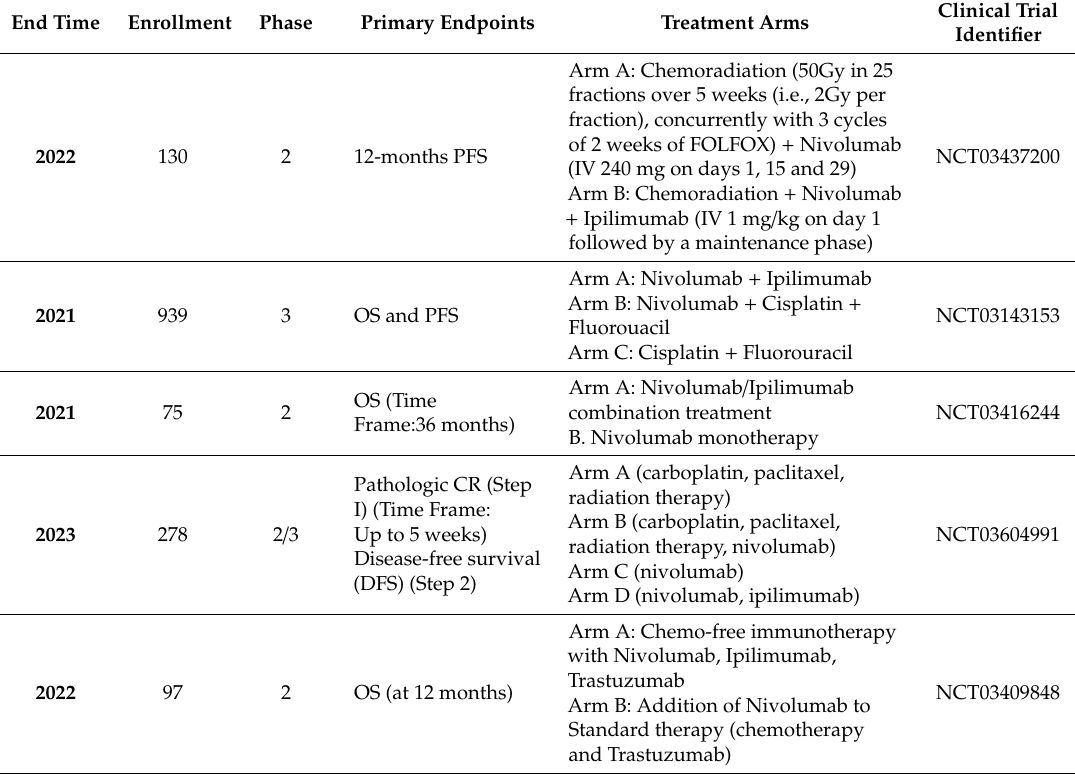
Table 6. Ongoing(untilJanuary2020)esophagealcancertrialsevaluatingNivolumab / Ipilimumabcombination. End